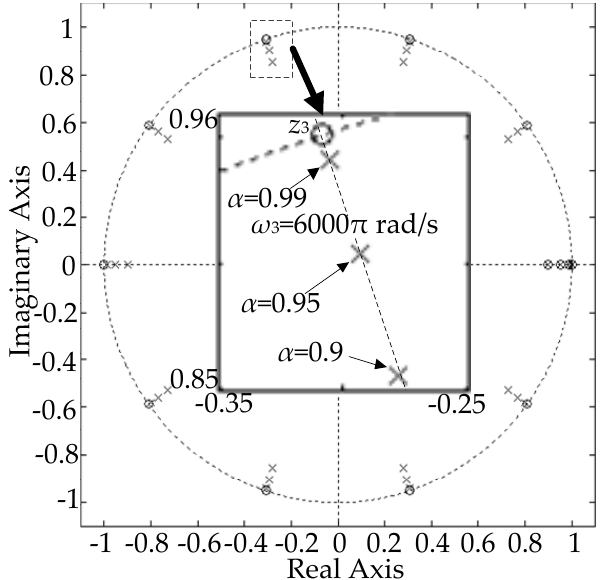
Figure 4. The z -plane, pole-zero pattern of MCF, with N = 10.